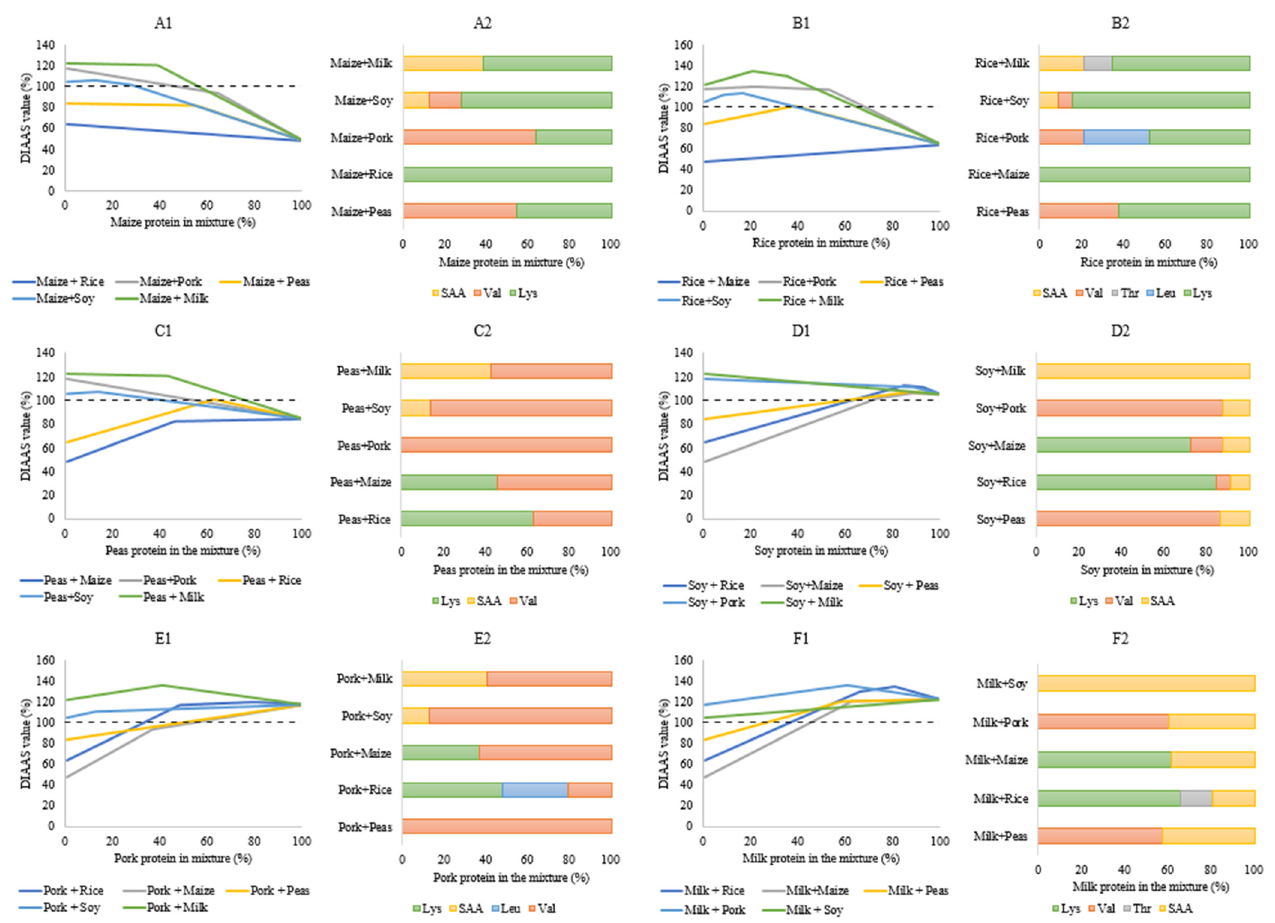
Figure 8. DIAAS value ( A1 , B1 , C1 , D1 , E1 , F1 ) and first limiting indispensable amino acid ( A2 , B2 , C2 , D2 , E2 , F2 ) for mixtures of protein from maize ( A1 , A2 ; data from [80]), rice ( B1 , B2 ; data from [80]), cooked peas ( C1 , C2 ; data from [87]), soy flour ( D1 , D2 ; data from [57]), pork belly ( E1 , E2 ; data from [76]) and skim milk powder ( F1 , F2 ; data from [57]) with any of the other 5 foods; Dashed line in ( A1 , B1 , C1 , D1 , E1 , F1 ) indicates a DIAAS value of 100%.